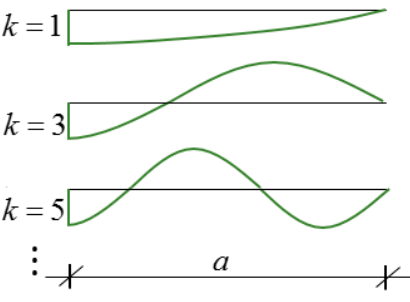
Figure 6. The displacement functions in Equation (13).